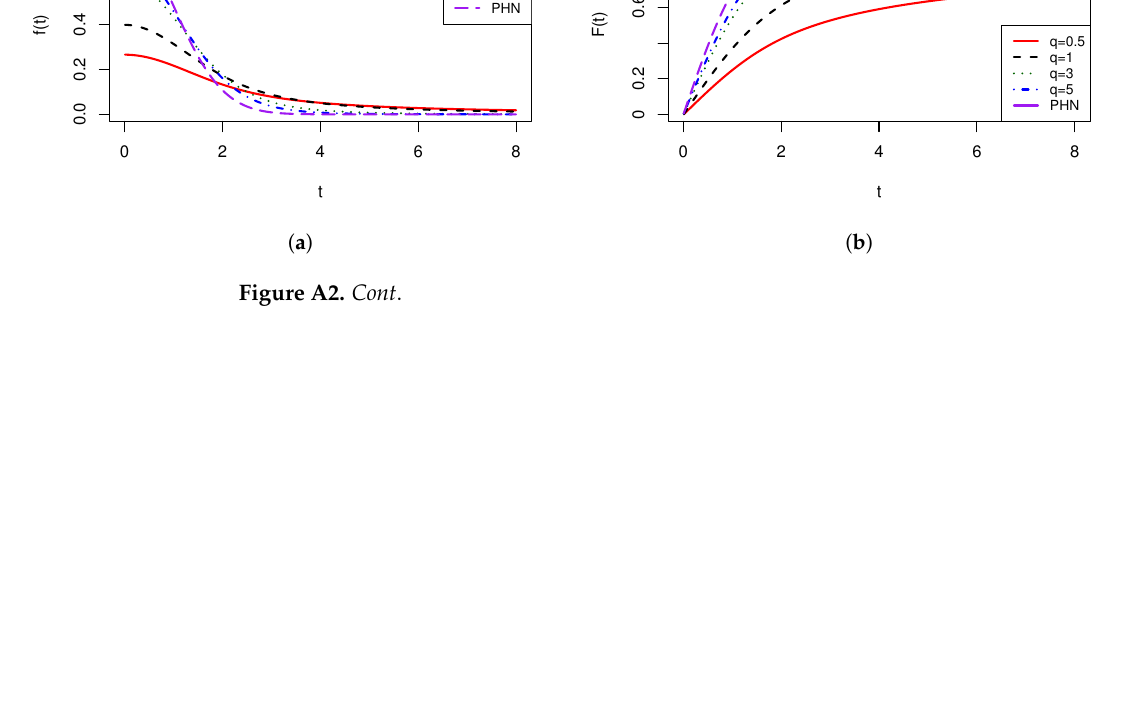
Figure A2. SPHN ( 1, α = 1, q ) = SHN ( 1, q ) for different values of q . In all panels, q = 0.5 (red), q = 1 (black), q = 3 (green), q = 5 (blue), and q = ∞ (purple). ( a ) pdf of SPHN ( 1, α = 1, q ) . ( b ) cdf of SPHN ( 1, α = 1, q ) . ( c ) Survival function of SPHN ( 1, α = 1, q ) . ( d ) hazard rate function of SPHN ( 1, α = 1, q ) . Appendix B In this appendix, the proof of Proposition 5 is given. (Proof of Proposition 5). From (6), we can write T q = X Y 1/ q , with q > 0, X ∼ PHN ( σ , α ) , and Y ∼ U ( 0,1 ) . Recall that if Y ∼ U ( 0,1 ) , then Y 1/ q ∼ Beta ( q ,1 ) , and therefore E (cid:16) Y 1/ q (cid:17) = q q + 1, Var (cid:16) Y 1/ q (cid:17) = q ( q + 1 ) 2 ( q + 2 ) . By using Chebyshev’s inequality, we have that P h(cid:12) (cid:12) (cid:12) Y 1/ q − E [ Y 1/ q ] (cid:12) (cid:12) (cid:12) > e i ≤ q e 2 ( q + 1 ) 2 ( q + 2 ) , ∀ e > 0, (A1) and since the right-hand side of (A1) tends to zero as q → ∞ { Y 1/ q − E [ Y 1/ q ] } P −→ 0,